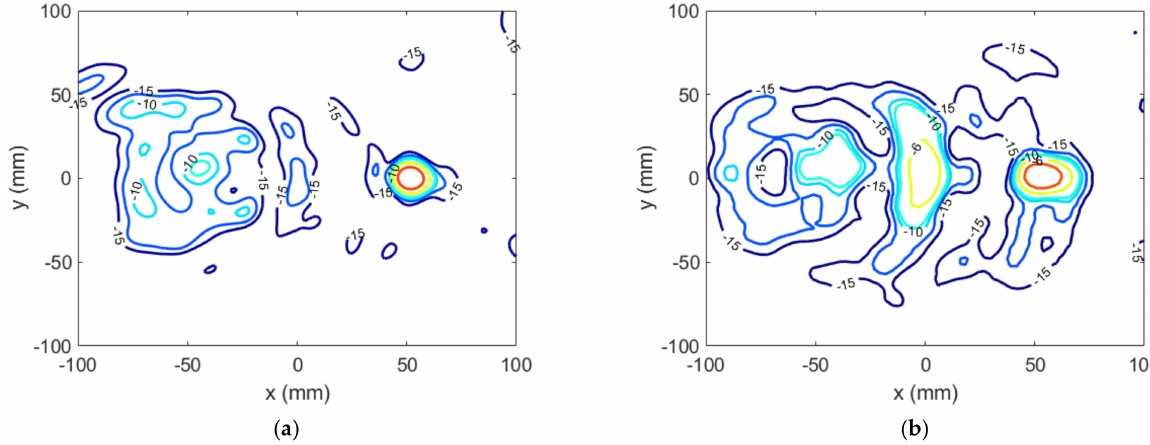
Figure 19. Case 2, NF normalized amplitude (dB) at z = 0.6 D around the focusing spot: ( a ) model result; ( b )